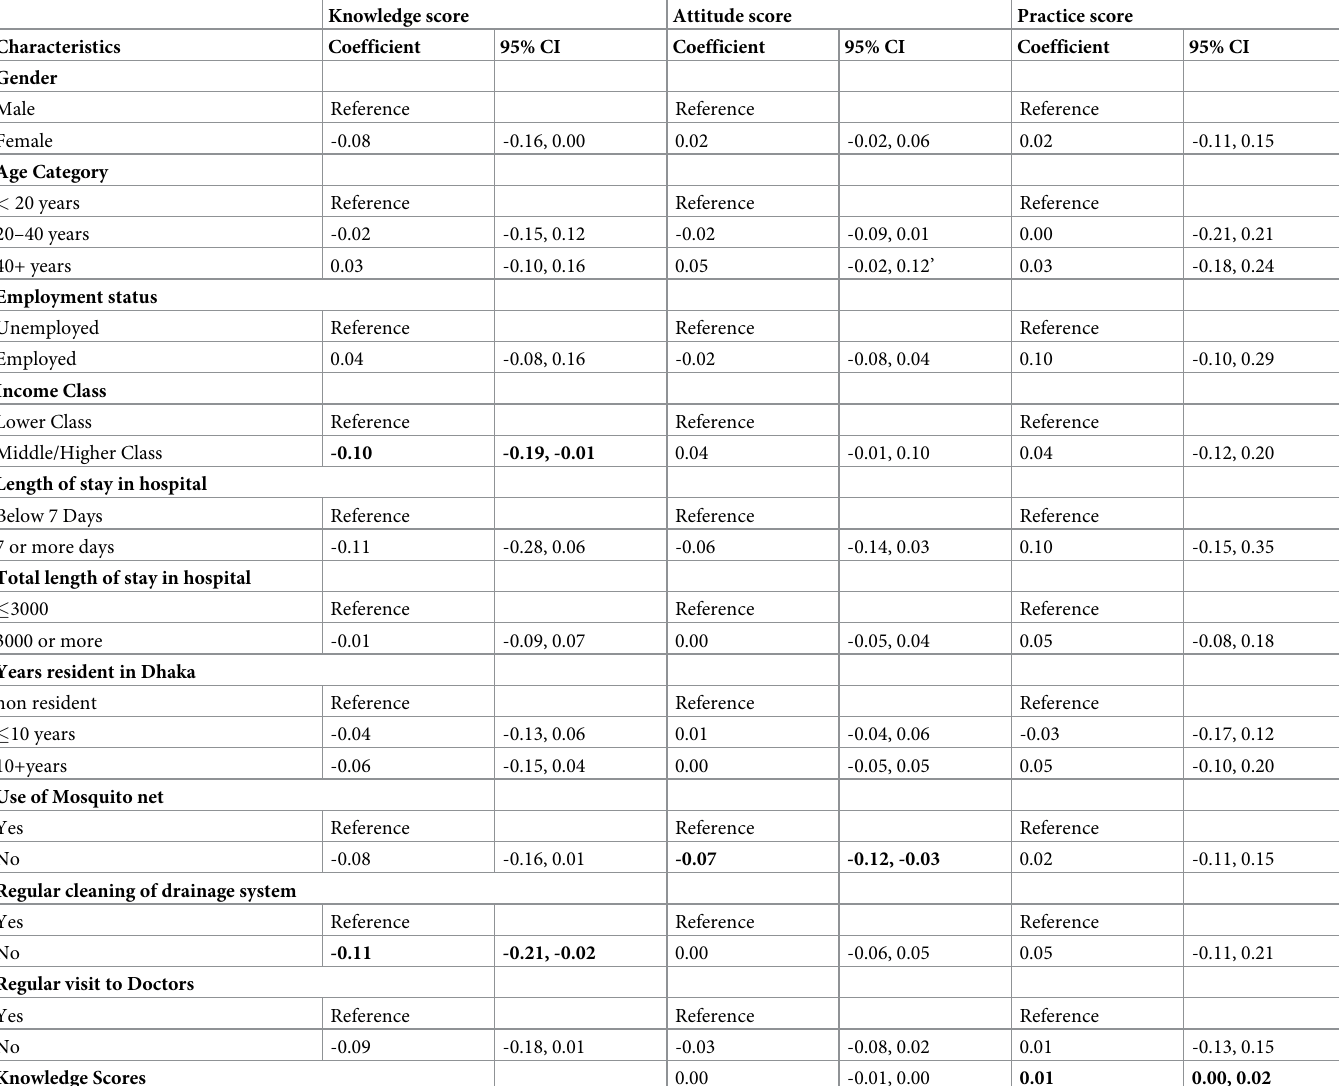
Table 4. Adjusted coefficients and 95% Confidence Intervals (CI) of multivariate analysis for factors associated with knowledge, attitude and practice towards den- gue in Dhaka,